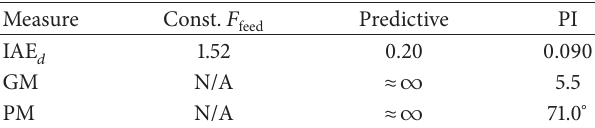
Table 4: Performance measures for three control strategies for controlling 𝑆 vfa